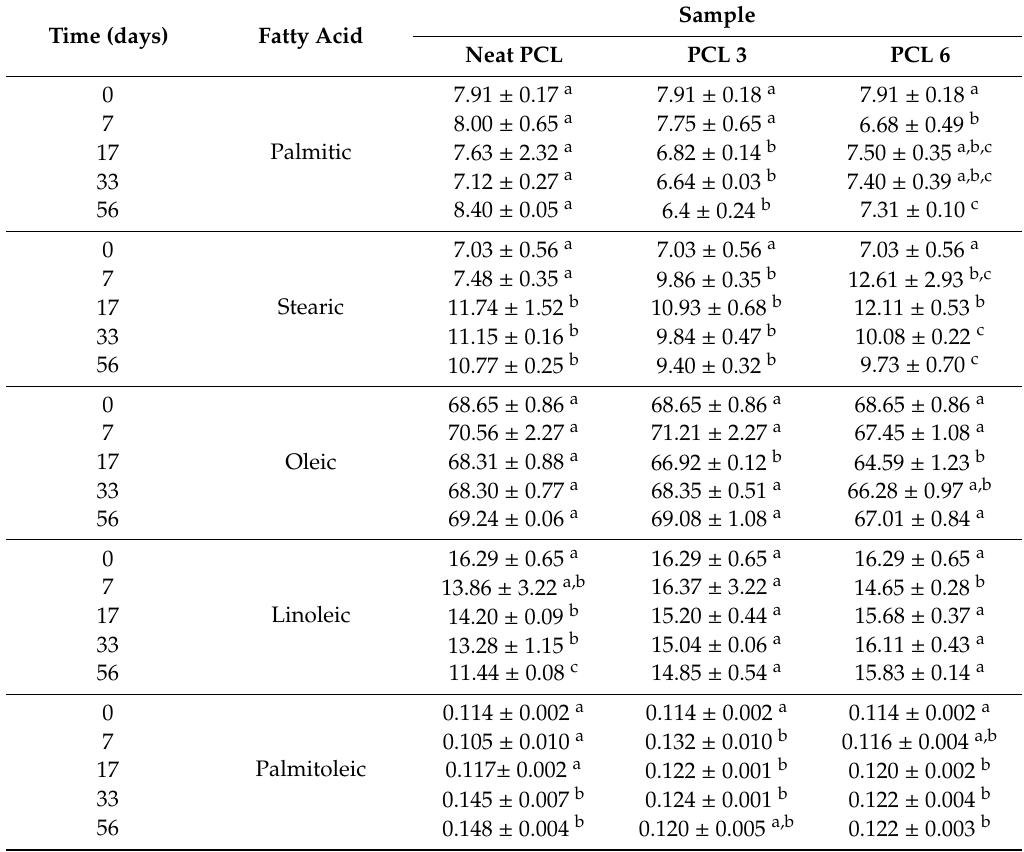
Table 3. Major fatty acid content of fried almonds (g fatty acid / 100 g of almond oil) packaged with neat PCL, PCL3 and PCL6 as a function of storage time at 40 ◦